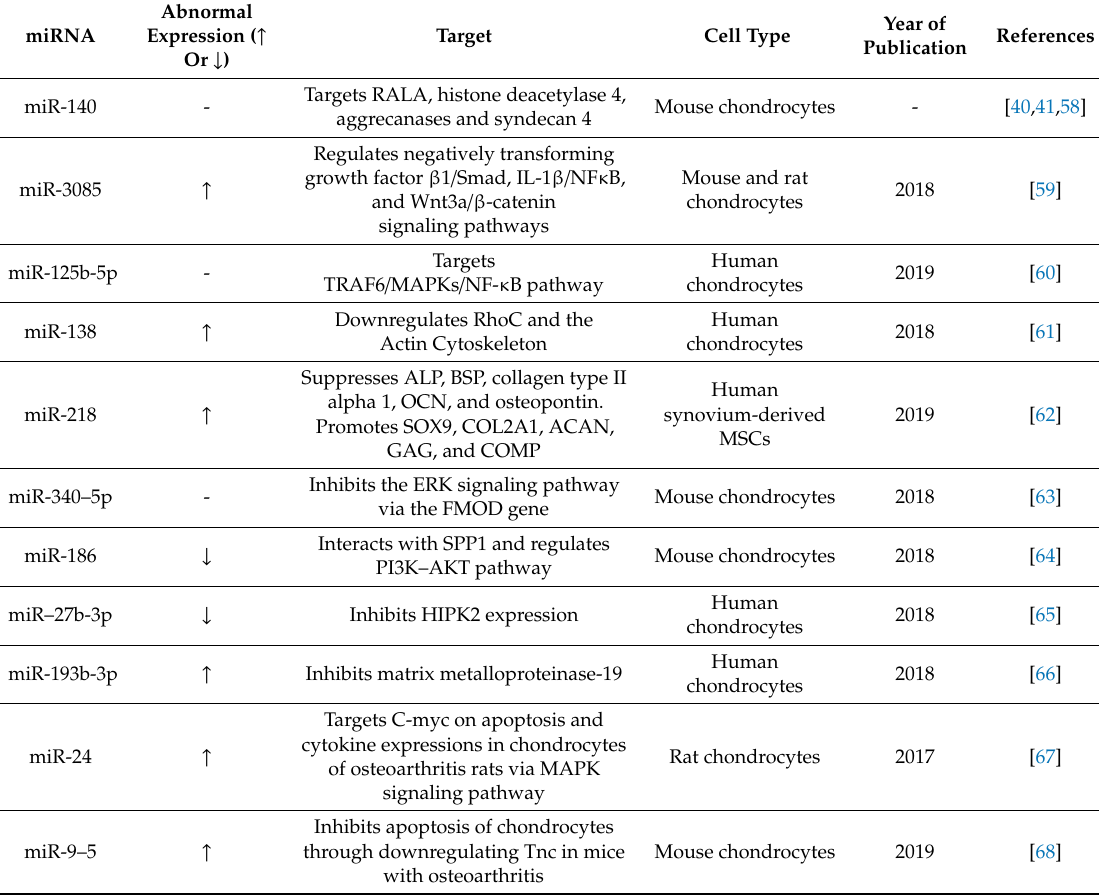
Table 1. Important microRNAs involving in chondrogenesis and chondrocyte